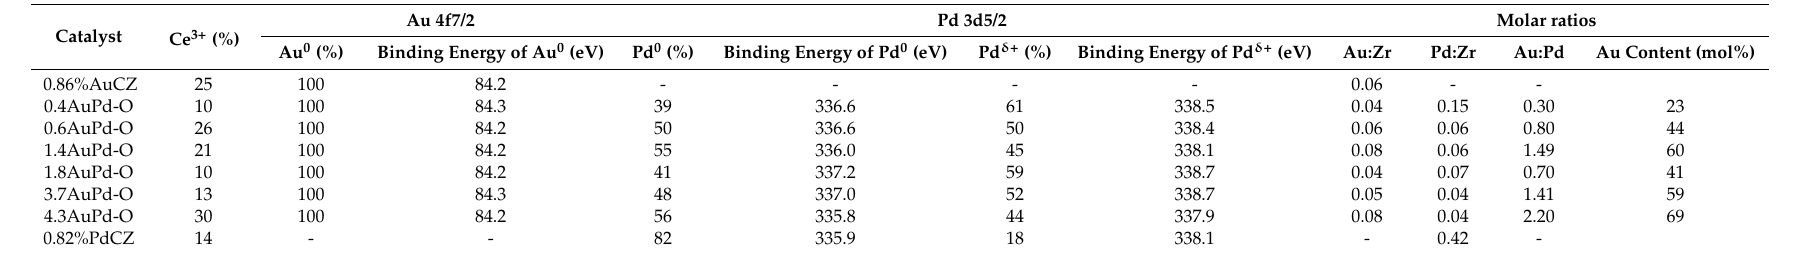
Table 3. Quantified XPS data of bimetallic catalysts with different Au:Pd